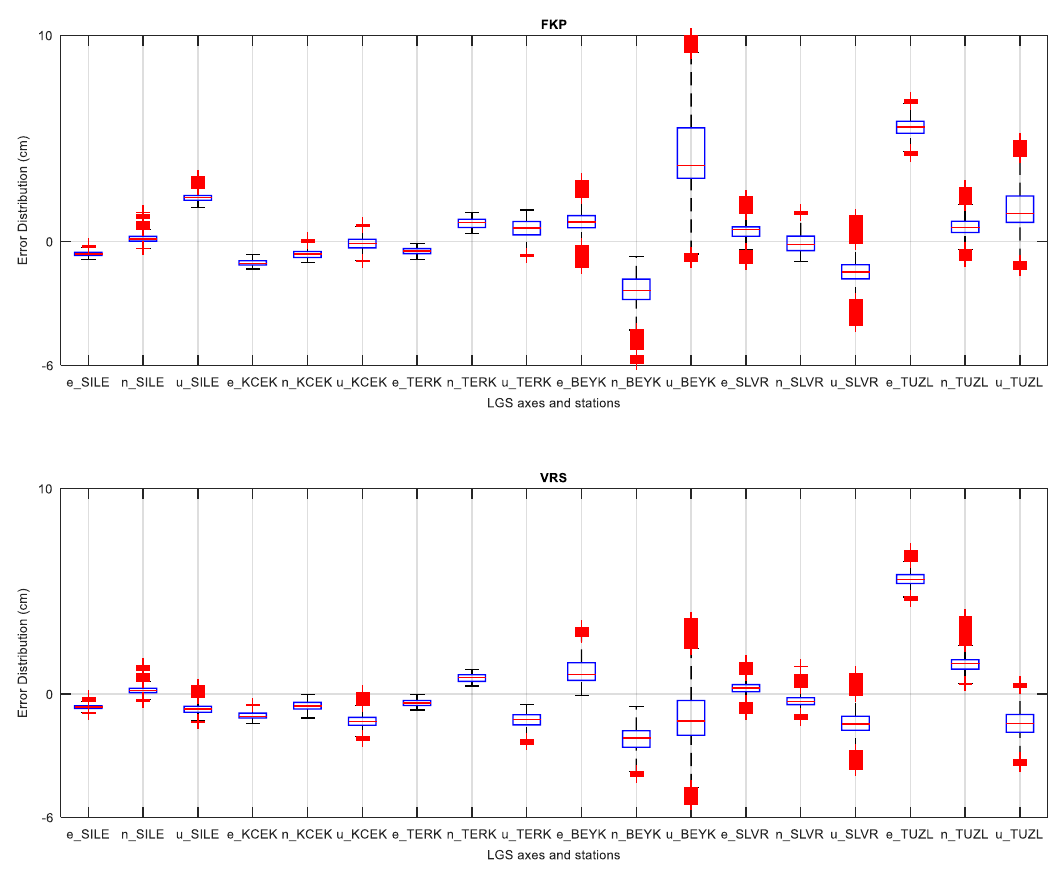
Table 2. RMSE and standard deviation values for the six test points. FKP Stations L (km) RMSE_e (cm) RMSE_n (cm) RMSE_u (cm) Std_e (cm) Std_n (cm) Std_u (cm) FIX Rate SILE